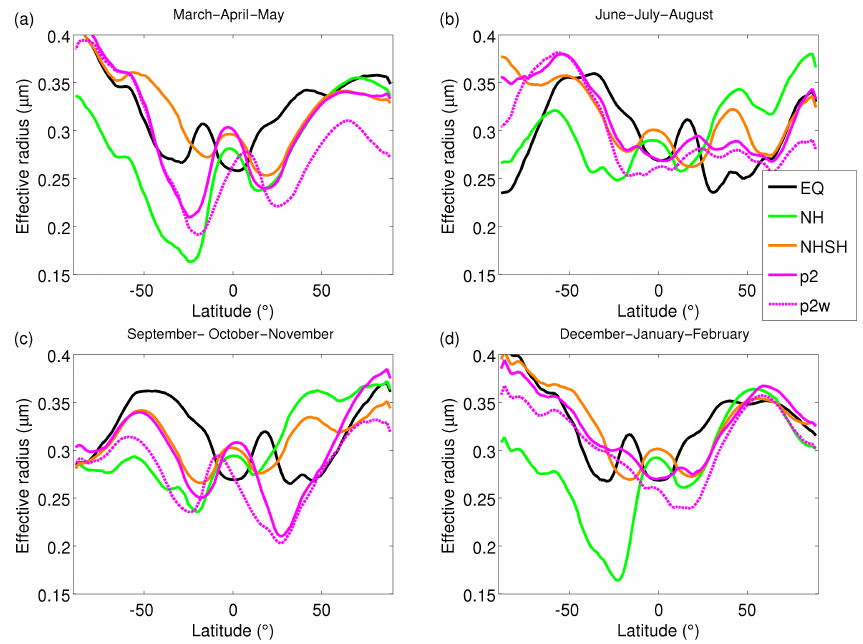
Figure 3. The zonal mean effective radius of the stratospheric particles in (a) March–April–May, (b) June–July–August, (c) September– October–November and (d) December–January–February.